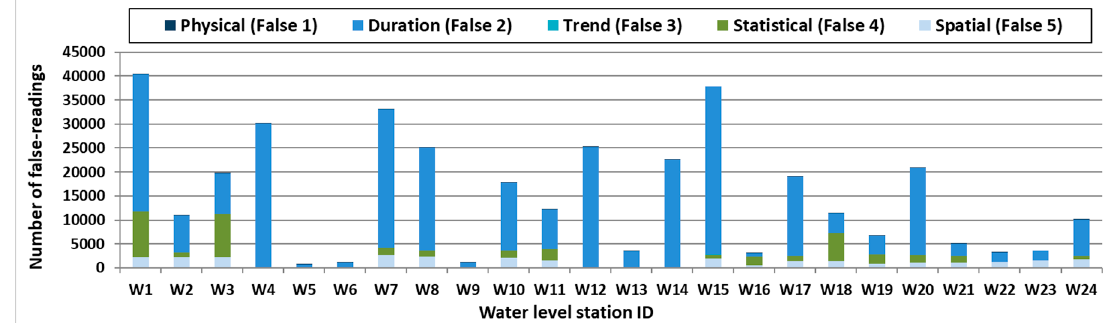
Figure 9. False data validation results of 24 water level stations.